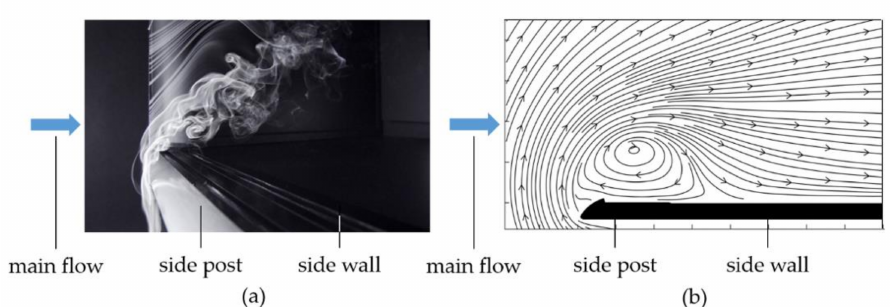
Figure 2. Flow separation and backflow at the side wall of the fume hood: ( a ) flow visualization with smoke wire technique and ( b ) streamlines deducted from PIV